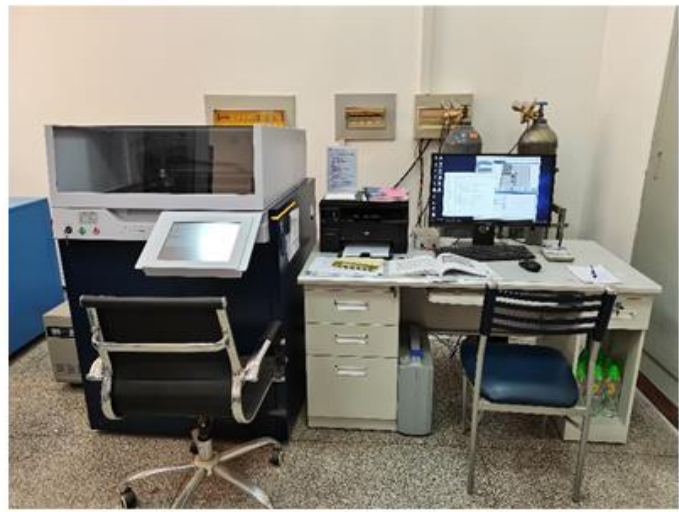
Figure 4. XRF equipment.